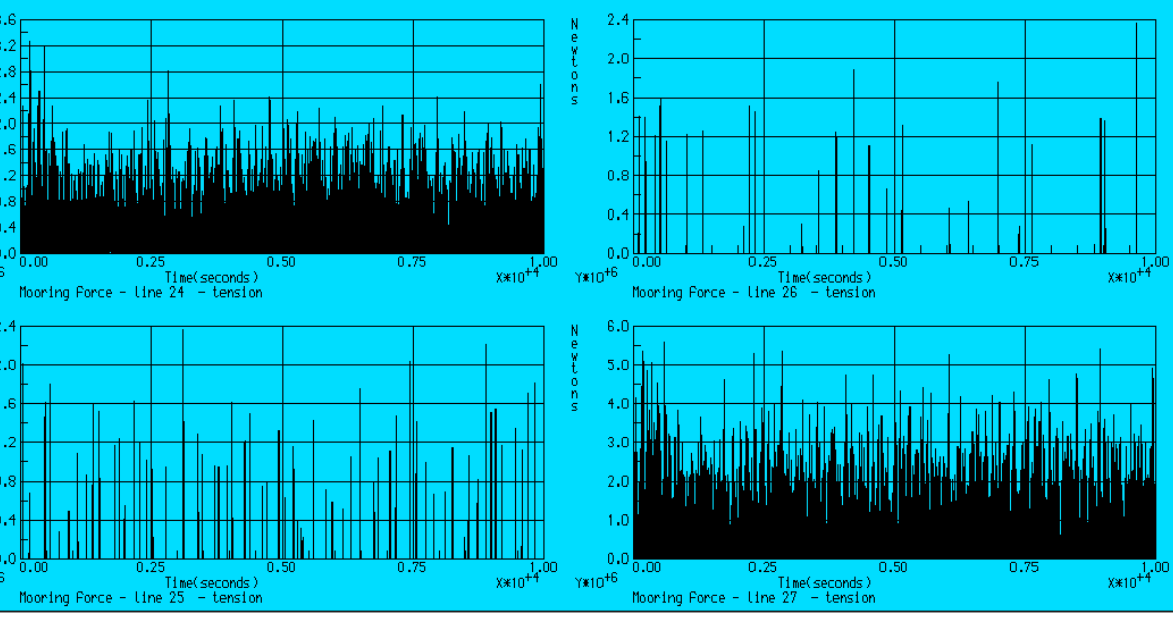
Figure 11. Sensitivity test—applied tension (N) on the berths’ mooring lines. Incoming wave angle of about 15 degrees from the head-on direction; otherwise, similar wave condition as for the c2 load case.